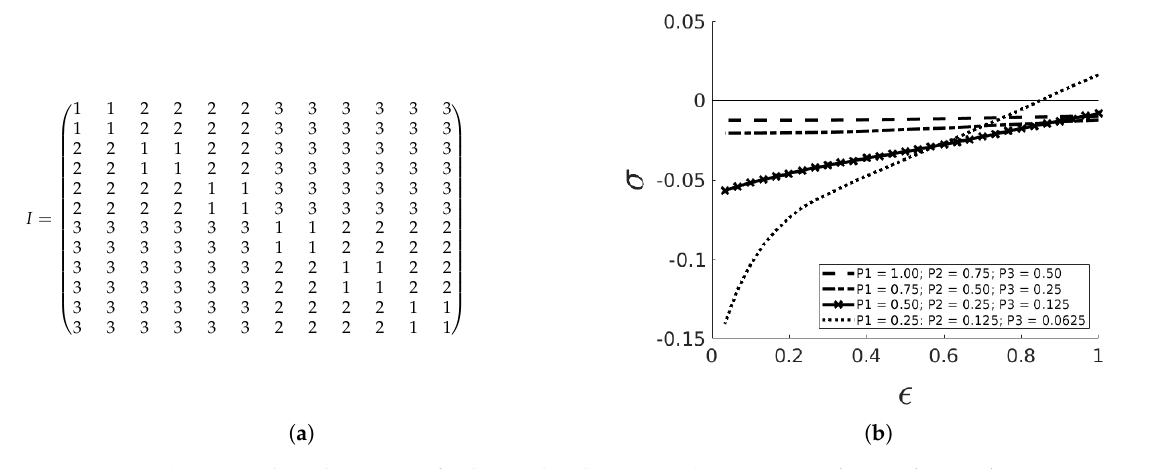
Figure 5. ( a ) Example index matrix for hierarchical matrices (communities l 1 = 2, l 2 = 6, l 3 = 2): for an entry k = I ij , the corresponding adjacency matrix has ones with probability p k . ( b ) Average intransitiveness index σ vs absorbency (cid:101) for hierarchical communities ( l 1 = l 2 = l 3 = 3, average over 1000 simulations).